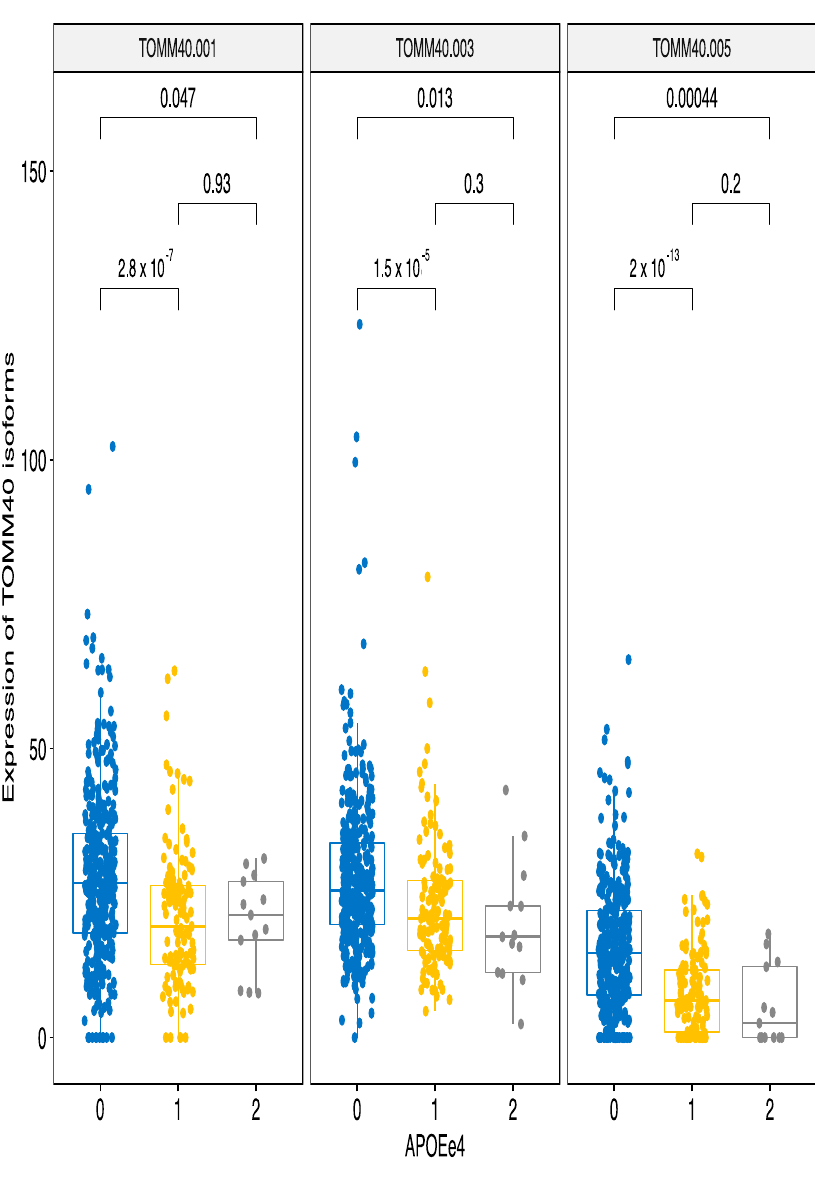
Figure 4. ApoE e4 haplotypes down-regulate expression of the TOMM40 transcripts 001, 003 and 005. Even a single e4 allele is sufficient to significantly reduce expression of the TOMM40 isoforms. The bars indicate pairwise comparisons and respective p -values after the Wilcoxon test.